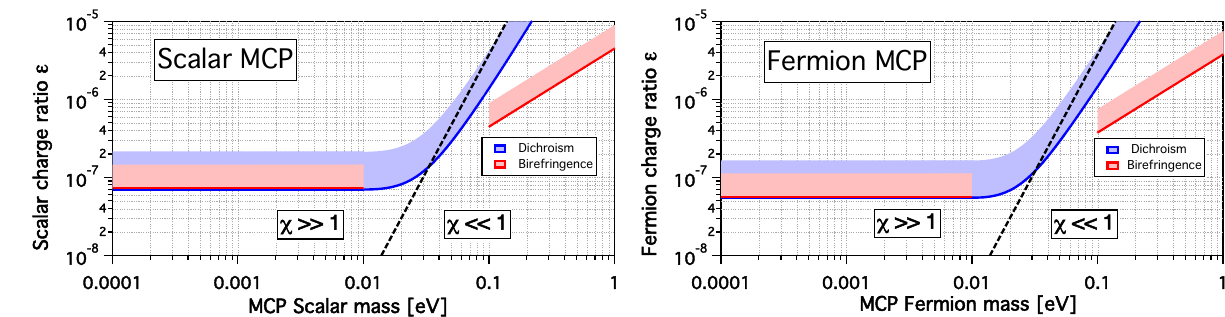
Figure 19. Laboratory exclusion plots based on equations in Section 1.1.2 for the existence of MCPs at 95% c.l. using the birefringence ( red ) and dichroism ( blue ) limits in Equations (64) and (66). The shaded regions of the graph are excluded. The two branches of the birefringence curve are not connected in the mass range around χ = 1 (dashed line), where ∆ n changes